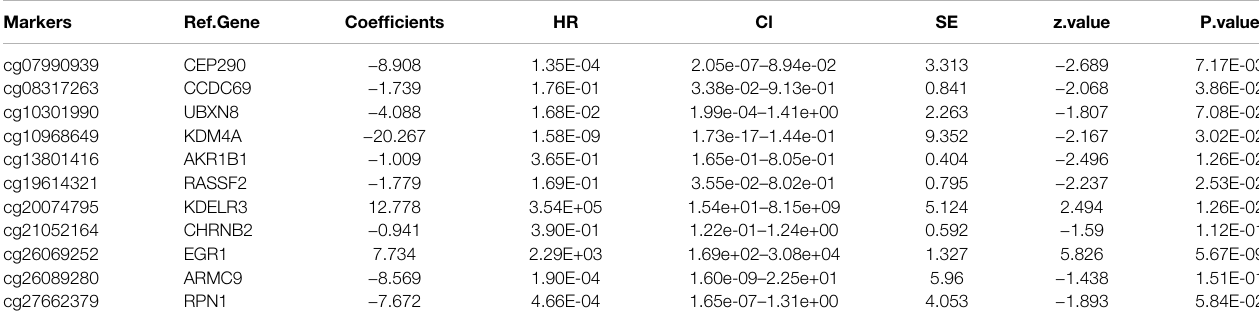
TABLE 3 | Characteristics of eleven methylation markers and their coef fi cients in GC prognosis prediction. Markers Ref.Gene Coef fi cients HR Cl SE z.value